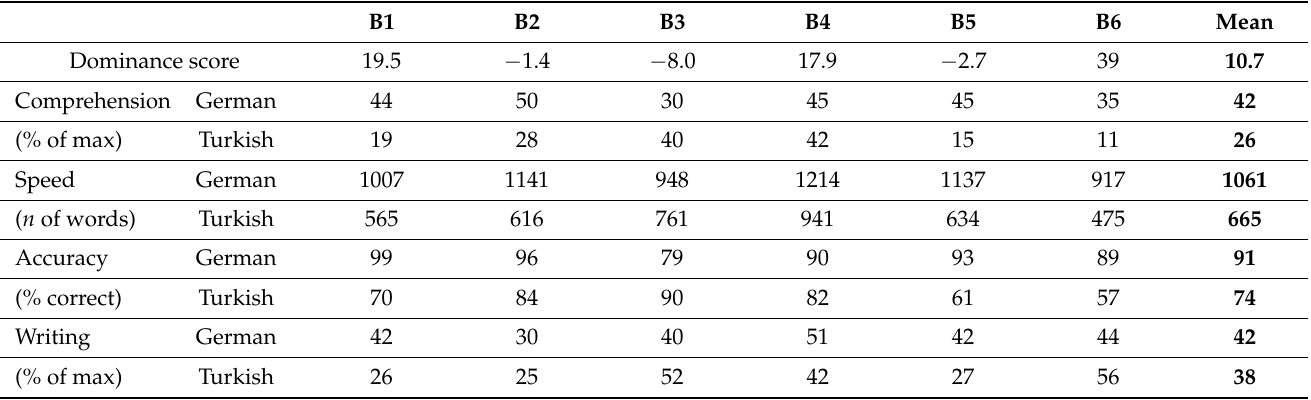
Table 4. Overview of different dominance measures (group B, averages over four measurements).